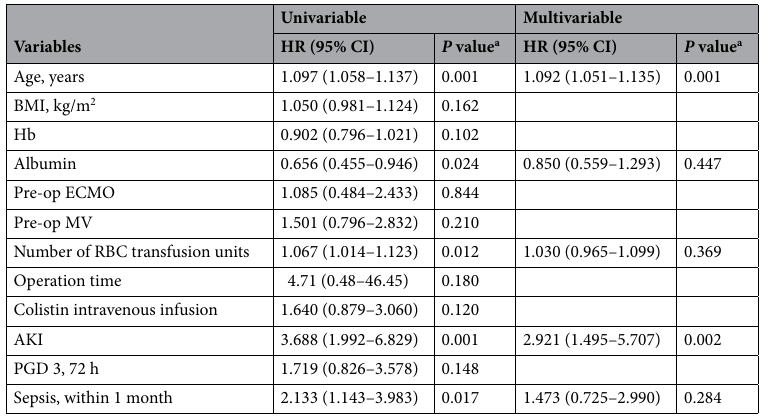
Table 5. Cox proportional hazard regression model for 1-year mortality after lung transplantation. BMI body mass index, Hb hemoglobin, ECMO extra corporeal membrane oxygenation, MV mechanical ventilation, RBC red blood cell, AKI acute kidney disease, PGD primary graft dysfunction. a P value determined by Cox proportional hazard